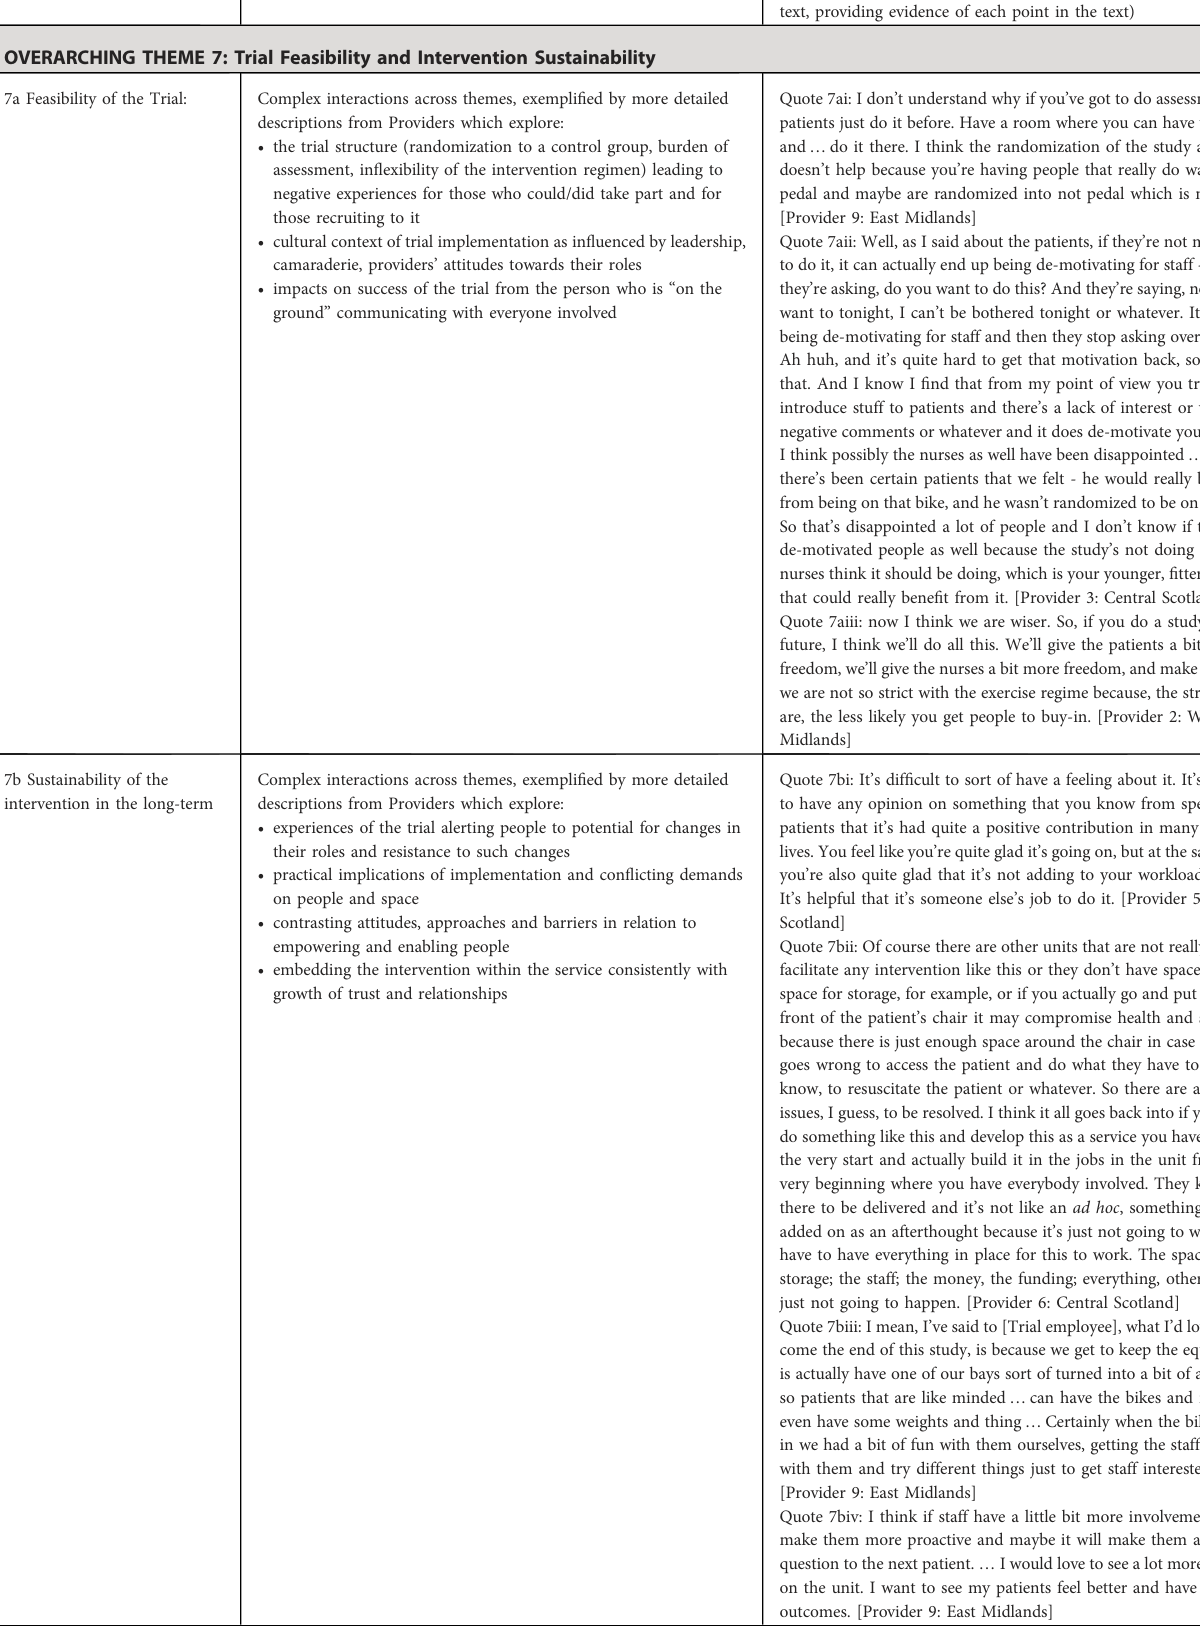
TABLE 3 Summary of data supporting interlinkages between all overarching themes in relation to trial feasibility and intervention sustainability. Sub-theme names (grouped by De fi nitions Theme – named in dividing rows)